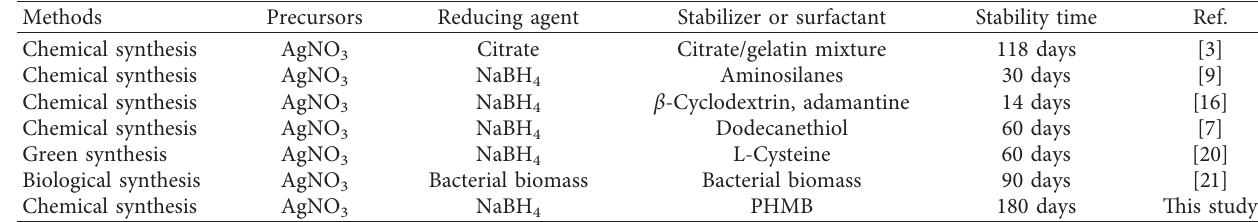
Table 2: Long-term stability of the colloidal